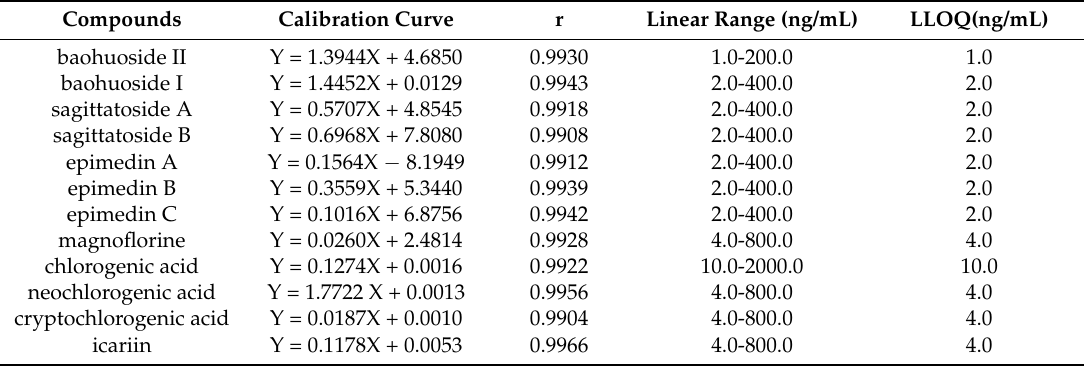
Table 1. Calibration curves, correlation coefficients, linear ranges and LLOQ of the analytes. Compounds Calibration Curve